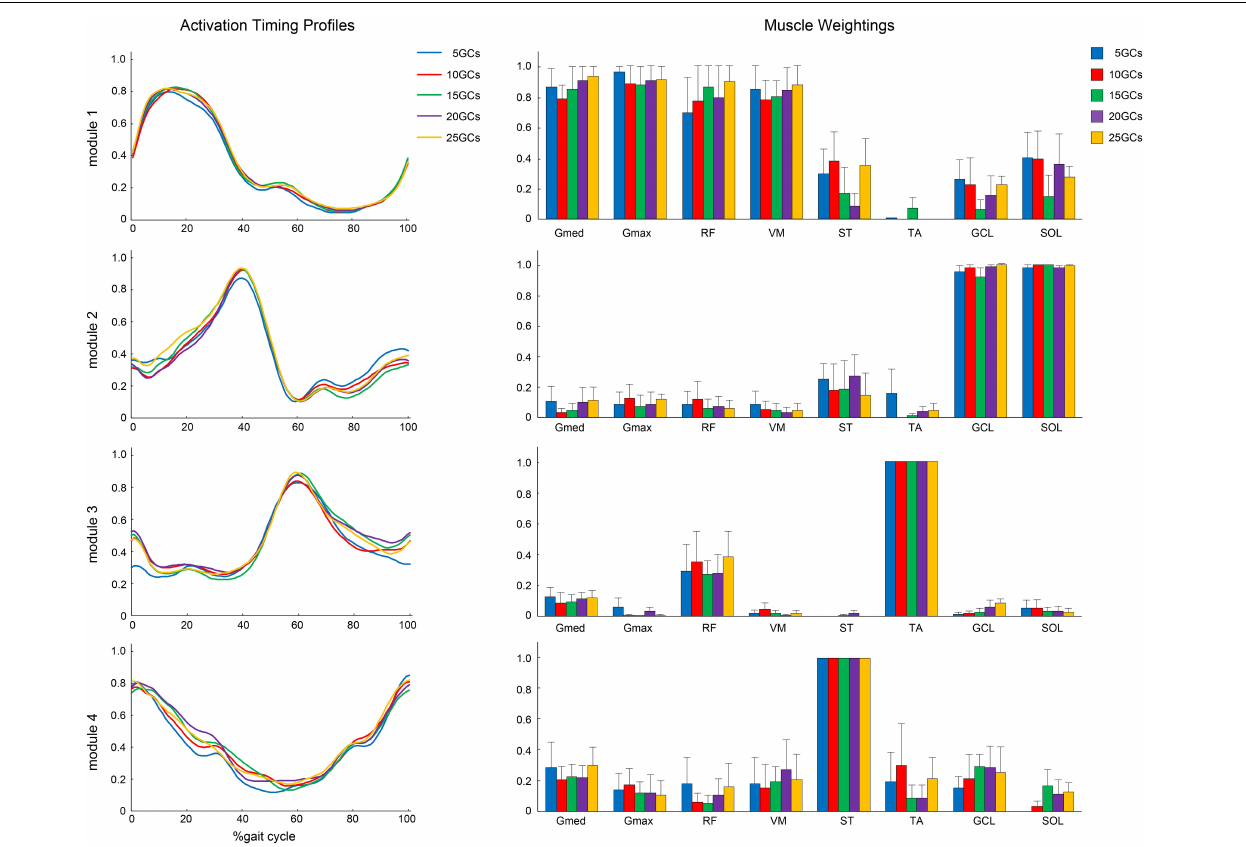
FIGURE 4 | The activation timing profiles and muscle weightings of assuming four modules. The effect of different GCs when the LPF was 4 Hz. Activation timing profiles are shown as the conditional mean. The bars of muscle weightings indicate the conditional median, and the error bars indicate the median absolute deviations. LPF, low-pass